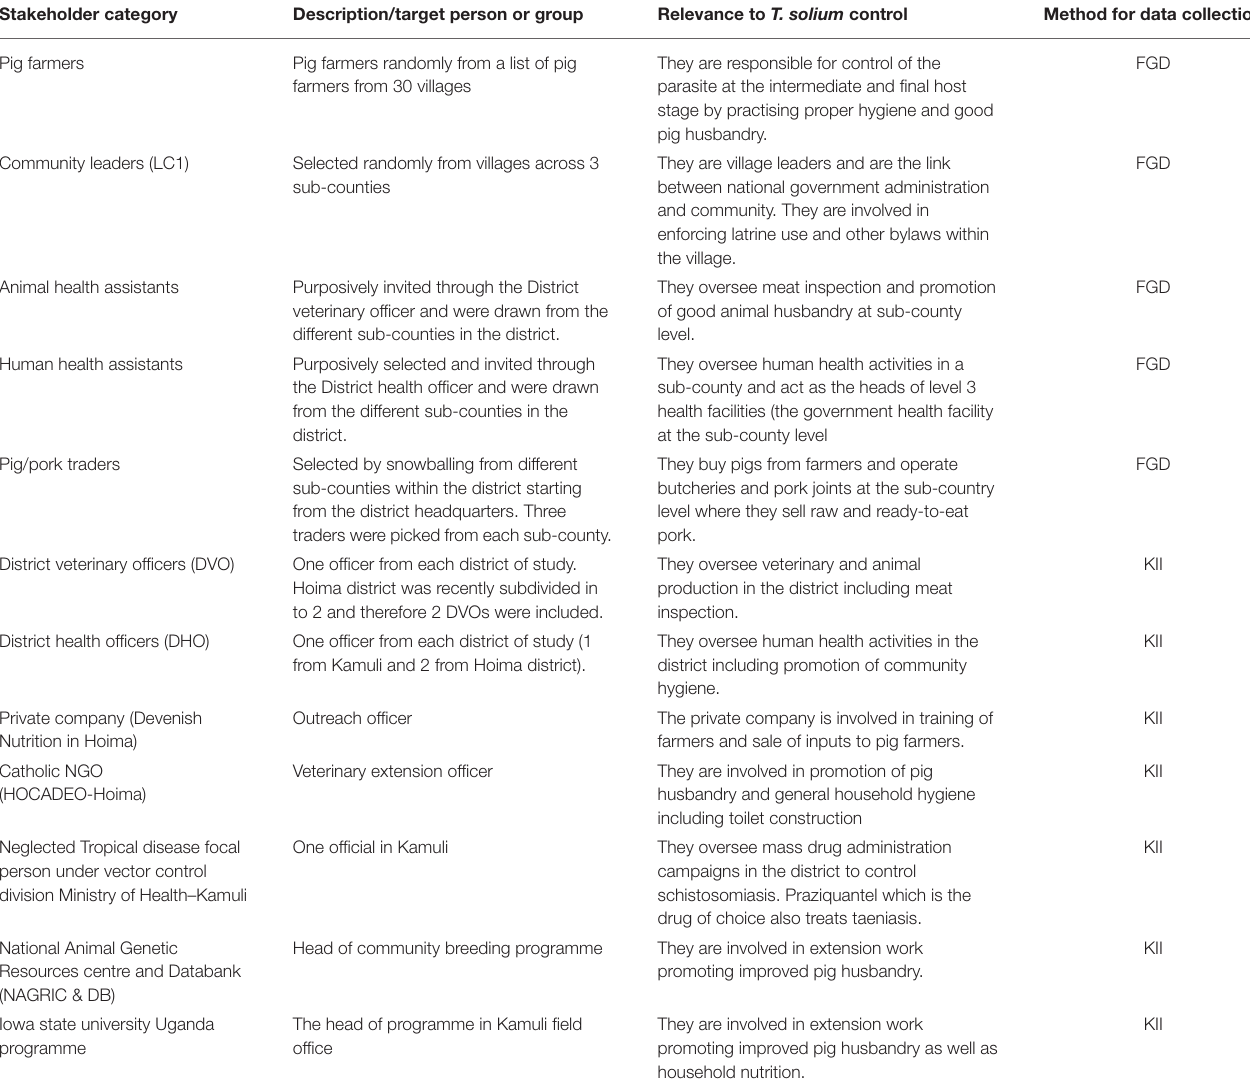
TABLE 1 | Stakeholder categories targeted for data collection and their description. Stakeholder